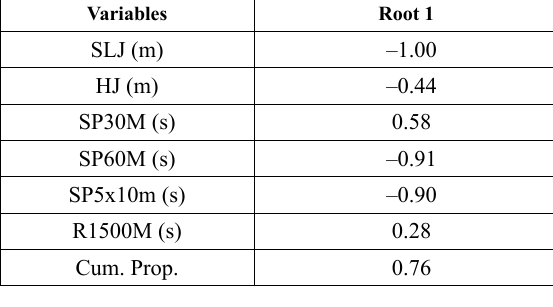
Table 3. Standardized coefficients for canonical variables